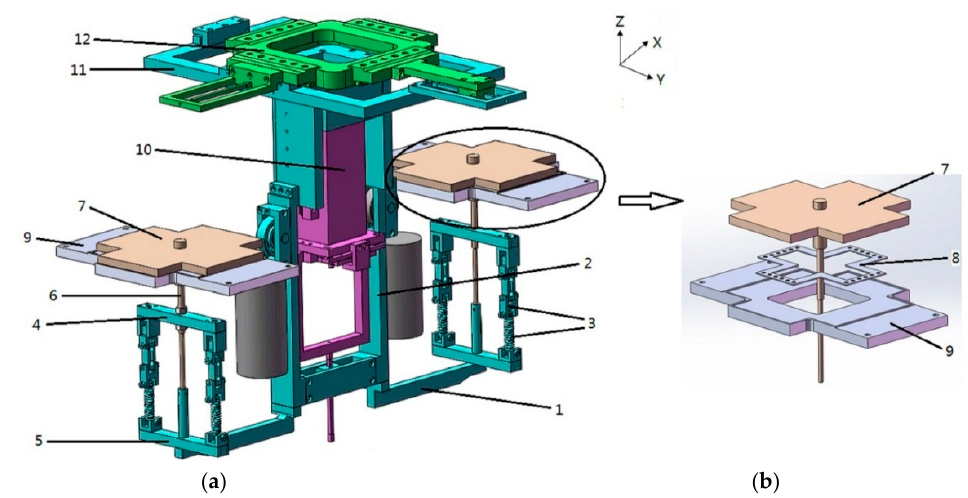
Figure 5. Schematic structure of the lateral deadweight balance system. 1: Horizontal arm, 2: Outer frame, 3: Spring and tension sensor, 4: Upper arm, 5: Lower arm, 6: Guide rod, 7: Upper plate, 8: Rolling bearing group, 9: Lower plate, 10: Z ‐ stage, 11: Y ‐ stage, 12: X ‐ stage.